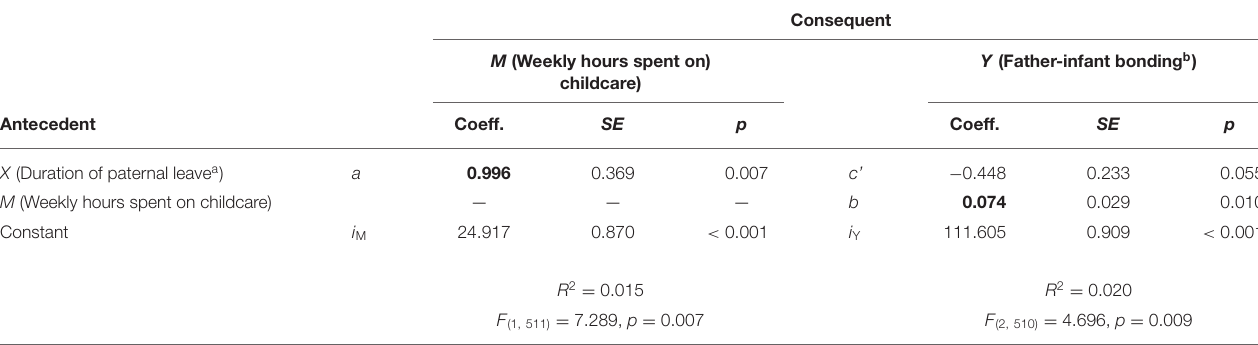
TABLE 3 | Model coefficients for the simple mediation analysis of the association between duration of paternal leave and father-infant bonding through weekly hours spent on childcare without confounders. Consequent M (Weekly hours spent on) Y (Father-infant bonding b ) childcare) Antecedent Coeff. SE p Coeff.